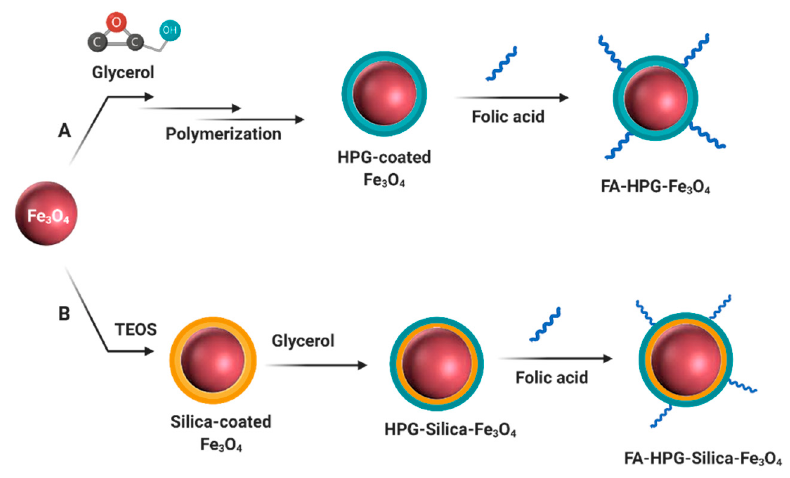
Figure 10. Synthesis and preparation of folic acid decorated nanoparticles.